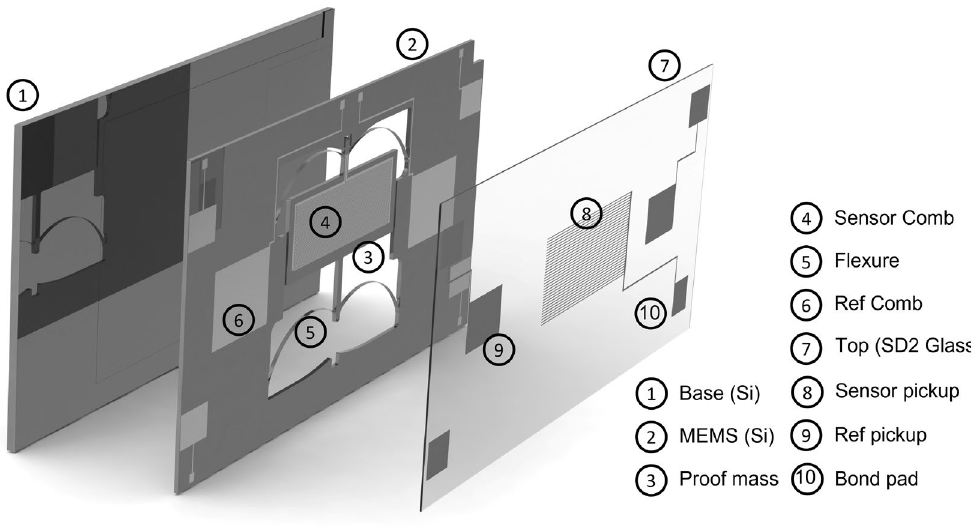
Figure 1. The MEMS device. An exploded view of the MEMS gravimeter assembly. The middle MEMS layer is mounted upon a base plate. The silicon base plate simply serves as a mechanical support for the MEMS layer. The MEMS layer has metal capacitive electrodes (combs) patterned on its surface. Corresponding pickup electrodes are patterned on an upper glass layer (made from SD2 silica), which is used to read out the signal